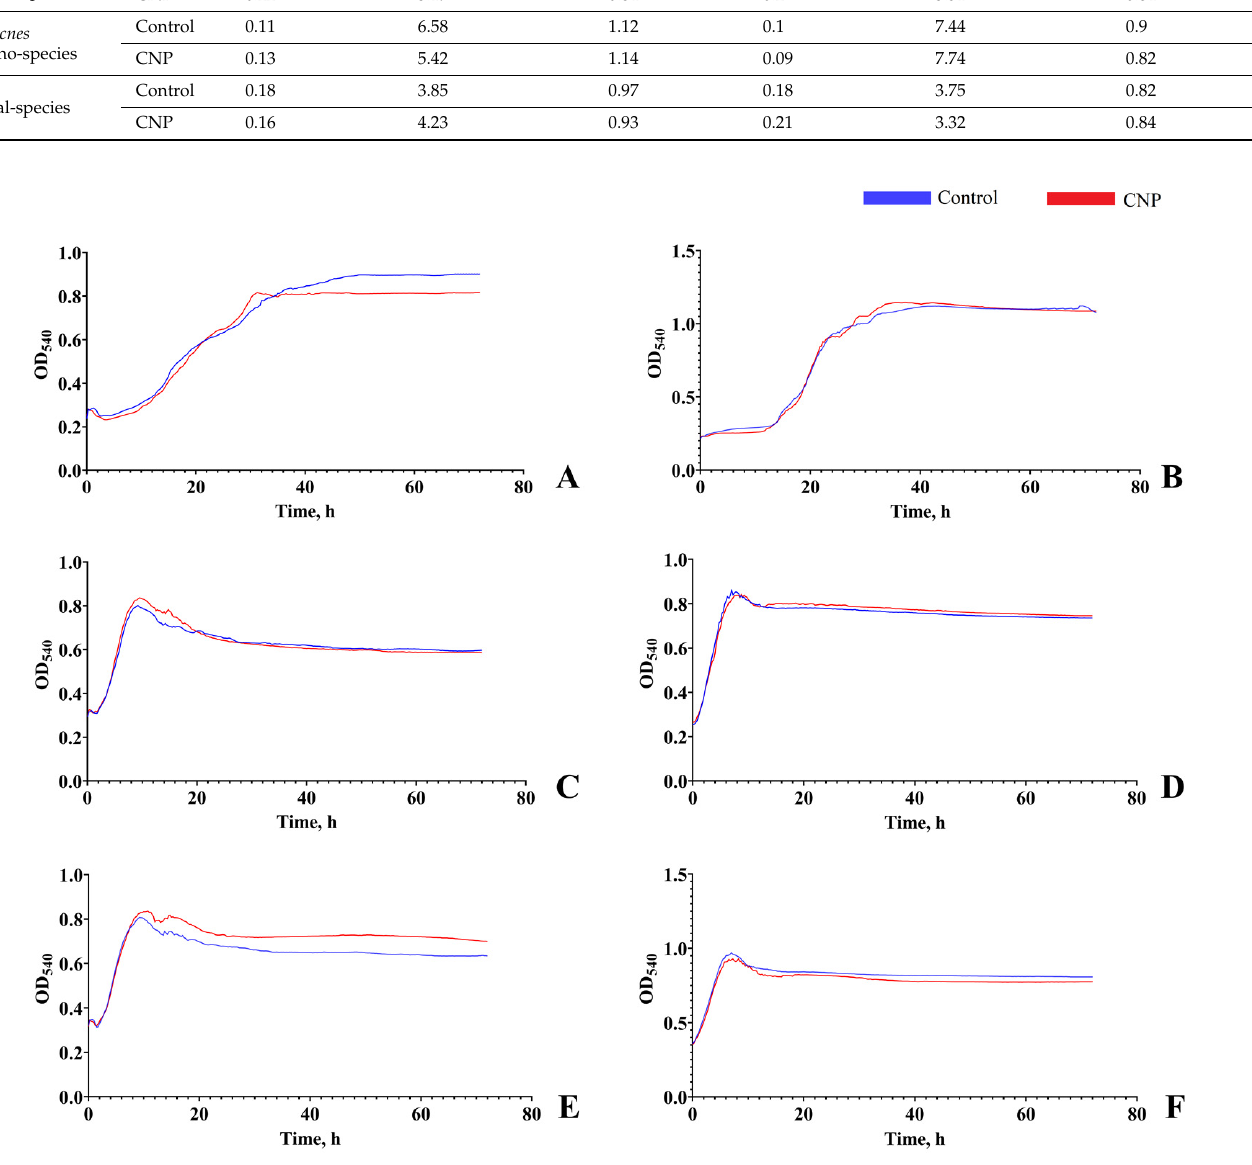
Figure 7. The growth curves for mono-species and dual-species cultures of S. epidermidis and C. acnes . ( A , C , E ), in the system with forced initial adhesion; ( B , D , F ), in the system without forced initial adhesion. ( A , B ), mono-species C. acnes ; ( C , D ), mono-species S. epidermidis ; ( E , F ), dual-species bio-